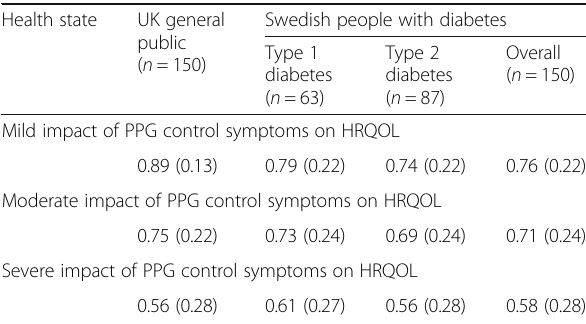
Table 3 Time trade-off (TTO) exercises in the UK ( n = 150) and Swedish ( n = 150) analysis sets, presented a mean (SD)